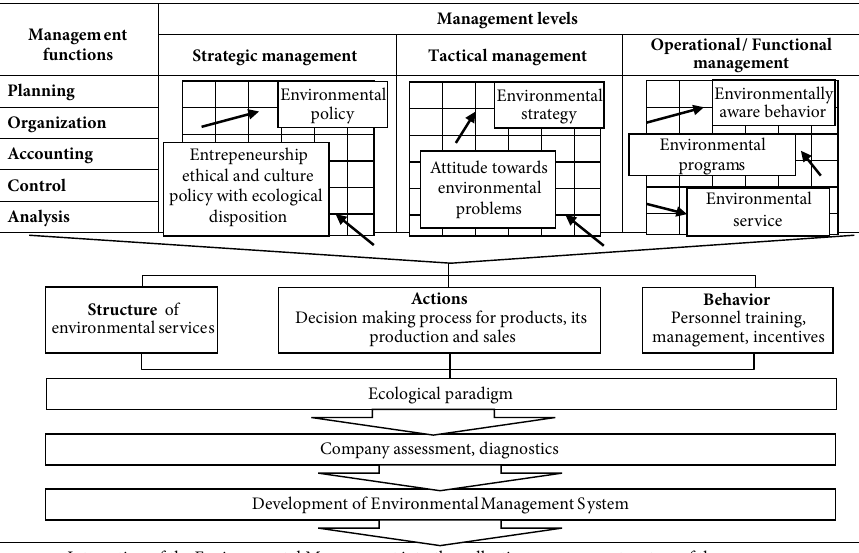
Fig. 3. Model for integration of Environmental Management into the collective management system of a